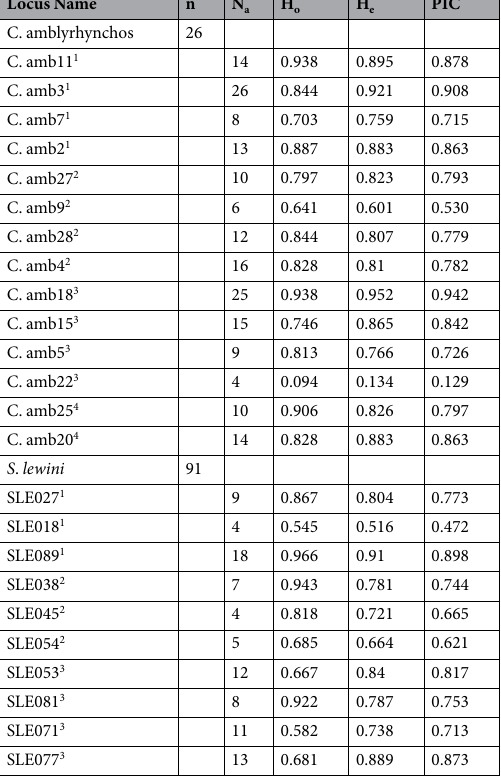
Table 1. Characterisation of microsatellite loci for grey reef sharks ( C. amblyrhynchos ) and scalloped hammerheads ( S. lewini ). Number of individual mothers and pups (n), number of alleles (N A ), observed heterozygosity (H o ), expected heterozygosity (H e ) and Polymorphic Information Criteria